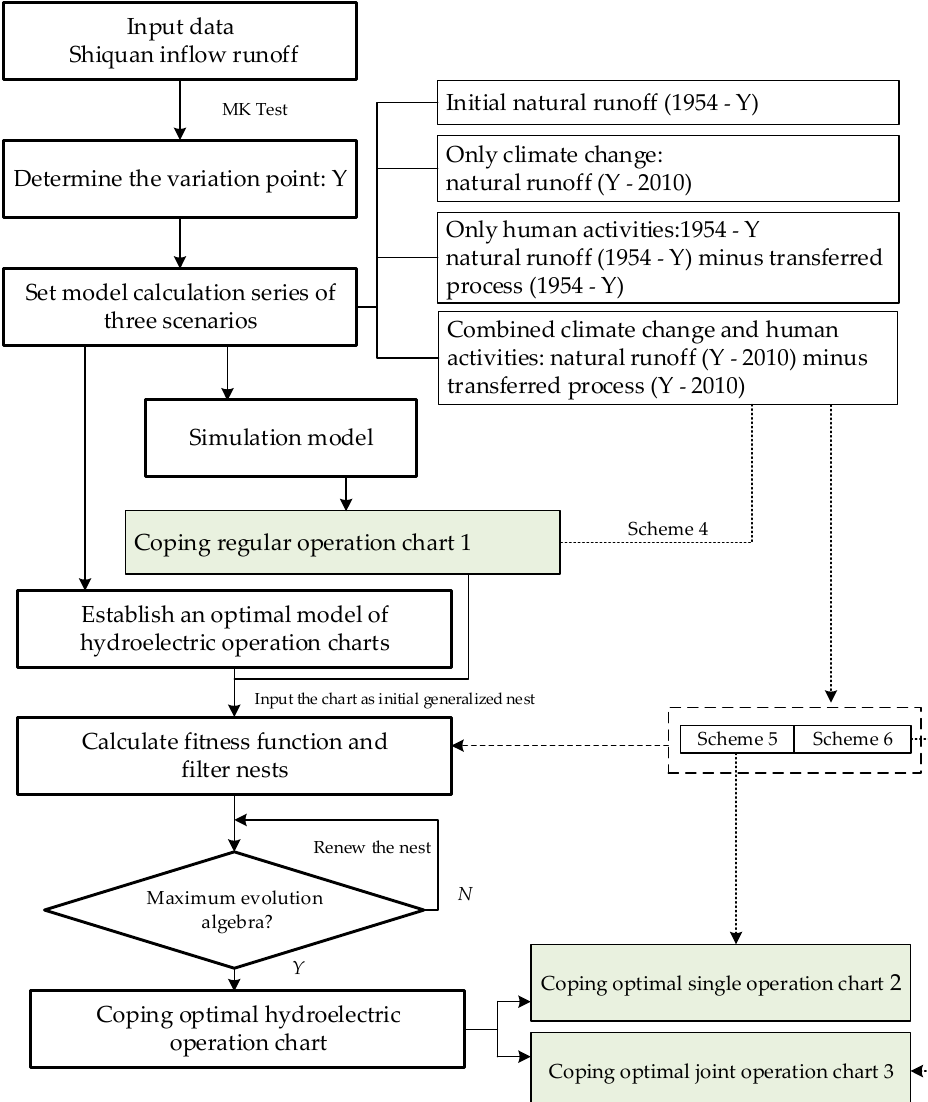
Figure 3. Flow chart for generating the optimal operation charts under climate change and human activities. See section 3.2 in the main text for definition of the different parts. MK = Mann-Kendall test.